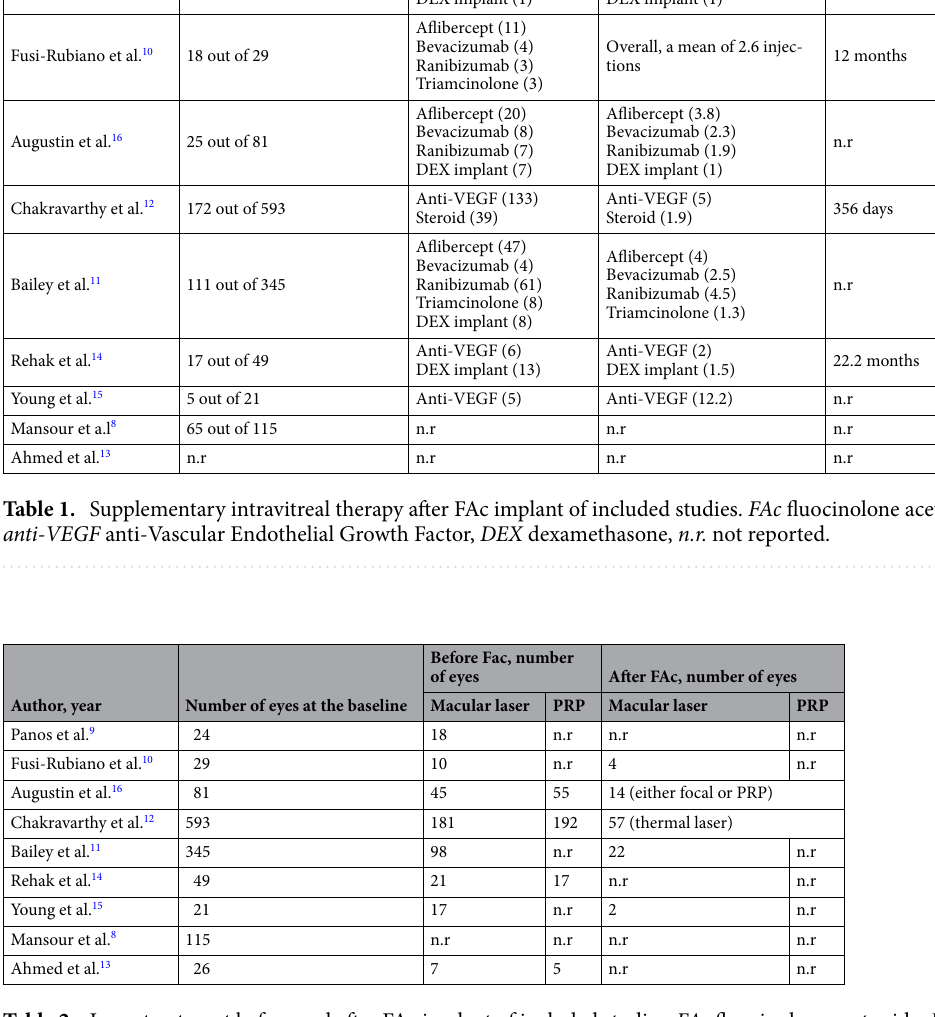
Table 2. Laser treatment before and after FAc implant of included studies. FAc fluocinolone acetonide, PRP panretinal photocoagulation, n.r . not reported.